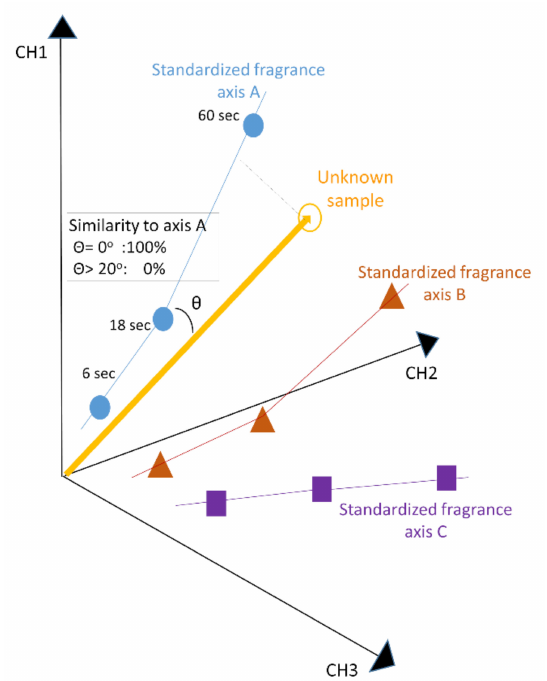
Figure 6. Scheme of measurement and calculation of similarities Schematic representation of the FF-2A algorithm. For more information, please refer to the main text of this paper. For simplicity, the figure shows the case where there are only three sensor